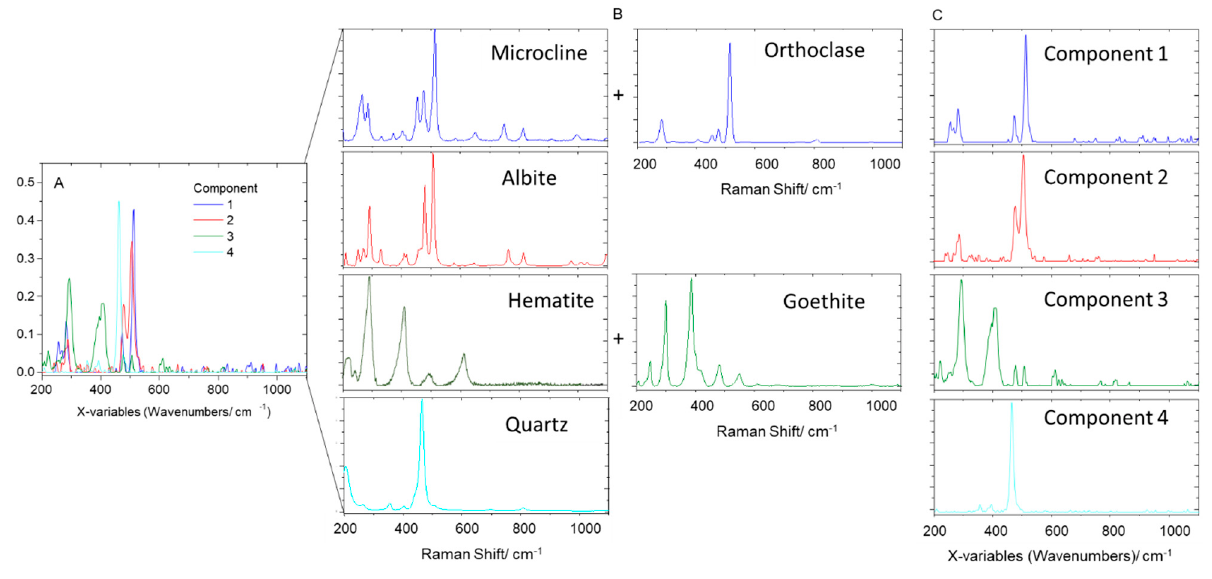
Figure 7. MCR components’ spectra ( A , C ) and Raman spectra of the identified minerals in the shell section of the studied fulgurite ( B ). The components’ spectra were vector-normalized in ( A ) and normalized by the most intense peak in ( C ); minerals’ spectra were normalized by the most intense peak. RRUFF reference spectra: microcline, R120005; orthoclase, X050126; albite, X050005; hematite, R060190; goethite, R120086; quartz,